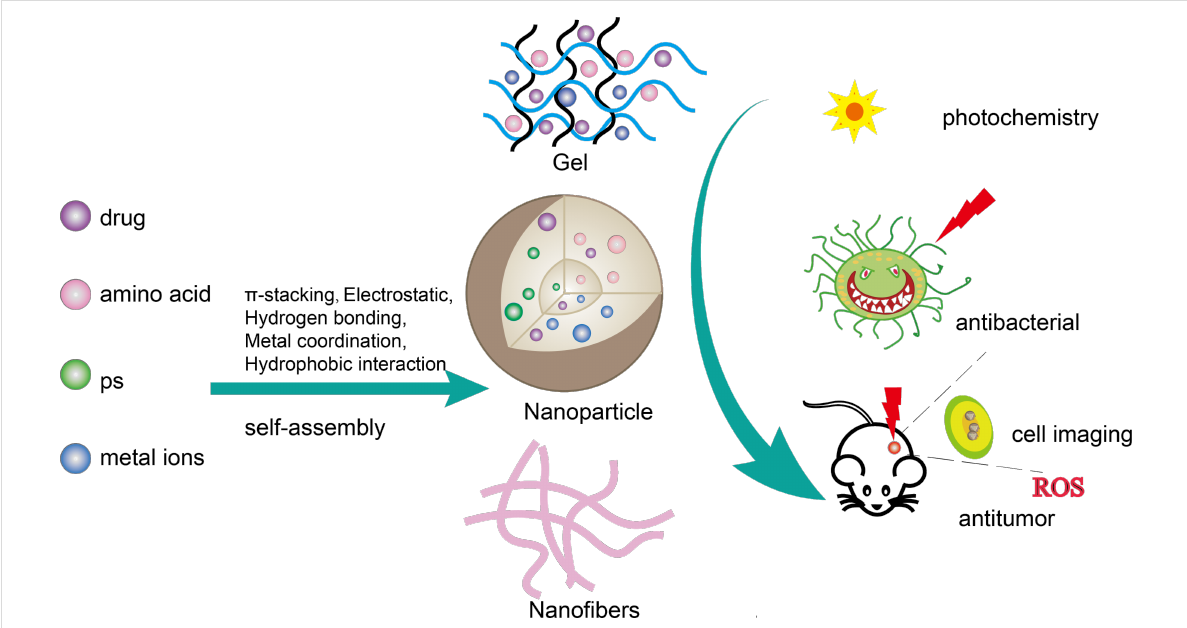
Figure 1: Schematic diagram of amino acid regulatory self-assembly (amino acid–drugs, amino acid–photosensitizers, amino acid–metal ions, multi- component collaborative self-assembly) as a general strategy for functional biomaterials research.